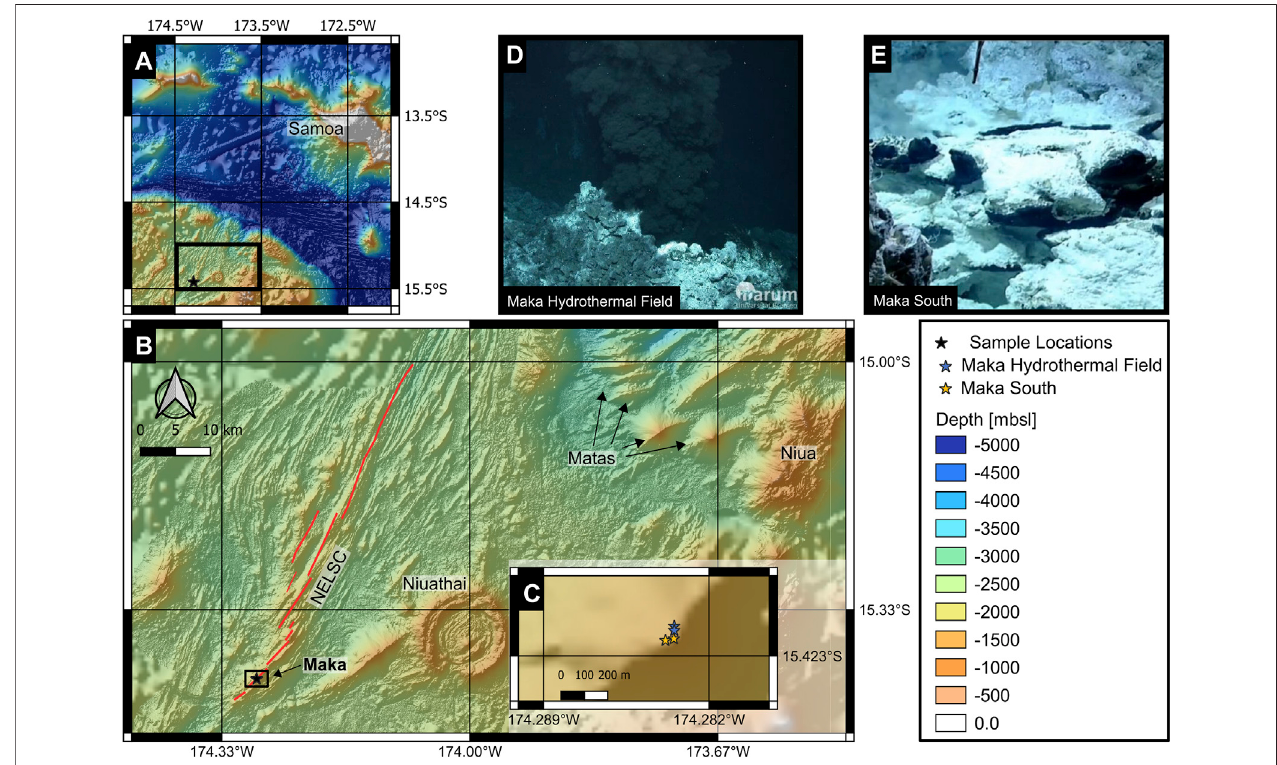
FIGURE 1 | (A) Large scale bathymetry of the northern Lau Basin, SW Paci fi c Ocean. The black star marks the study site situated within the North East Lau Basin. Bathymetric data taken from (GEPCO Compilation Group, 2021). (B) Detailed bathymetric map of the North East Lau Basin [black rectangle in (A) ]. The sample location at Makavolcanoismarkedwithablackstar. (C) SamplelocationatthetopofMakavolcano[blackrectanglein (B) ].Bathymetricdatapresentedin (B,C) takenfrom(Merleetal., 2018). (D, E) Active hydrothermal venting at Maka HF and Maka South. Photographs taken during ROV dives by MARUM QUEST 4000, University Bremen.